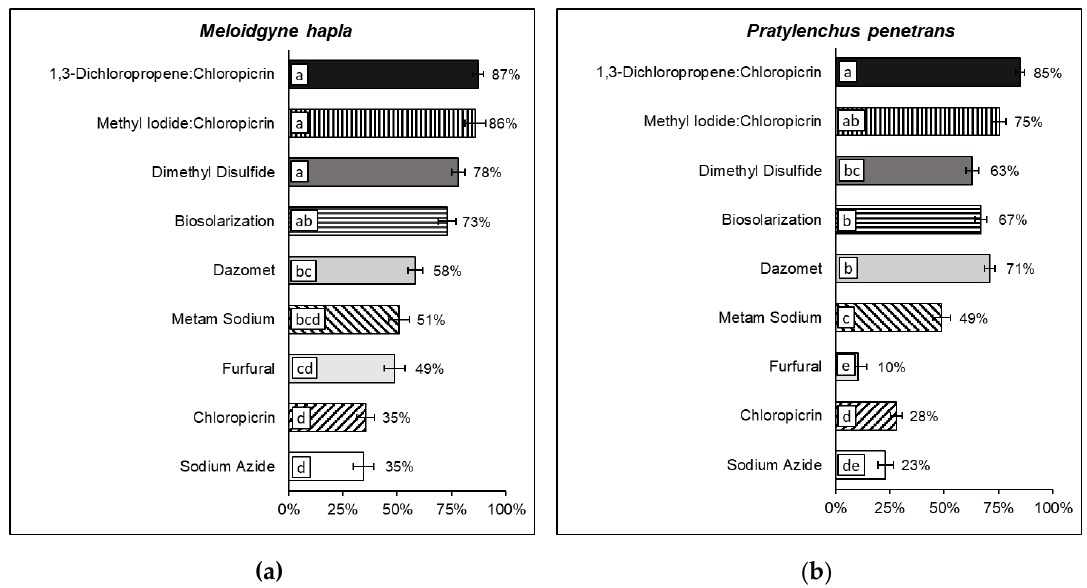
Figure 3. Relative efficacies of several soil disinfestations treatments in reducing Meloidogyne hapla ( a ) and Pratylenchus penetrans ( b ) soil densities in strawberry fields infested by the respective nematodes. Data are the mean of nine to thirty-six replicates depending on the treatment. Error bars represent the standard error of the mean. Bars with the same letter do not differ significantly according to the Bonferroni test ( p < 0.05).